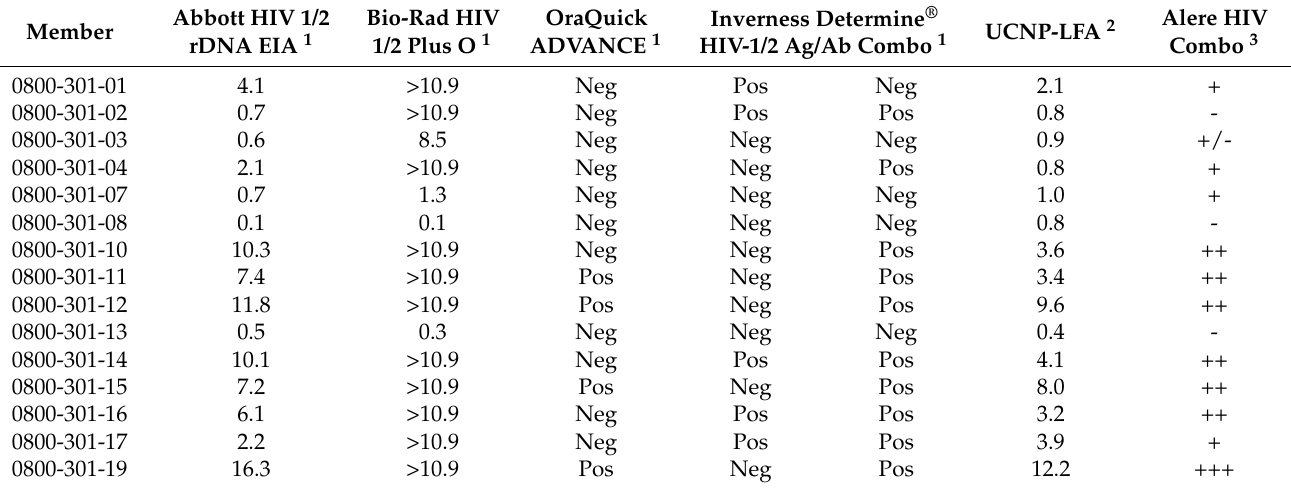
Table 6. Anti-HIV-1 Low Titer Panel (0800-0301).